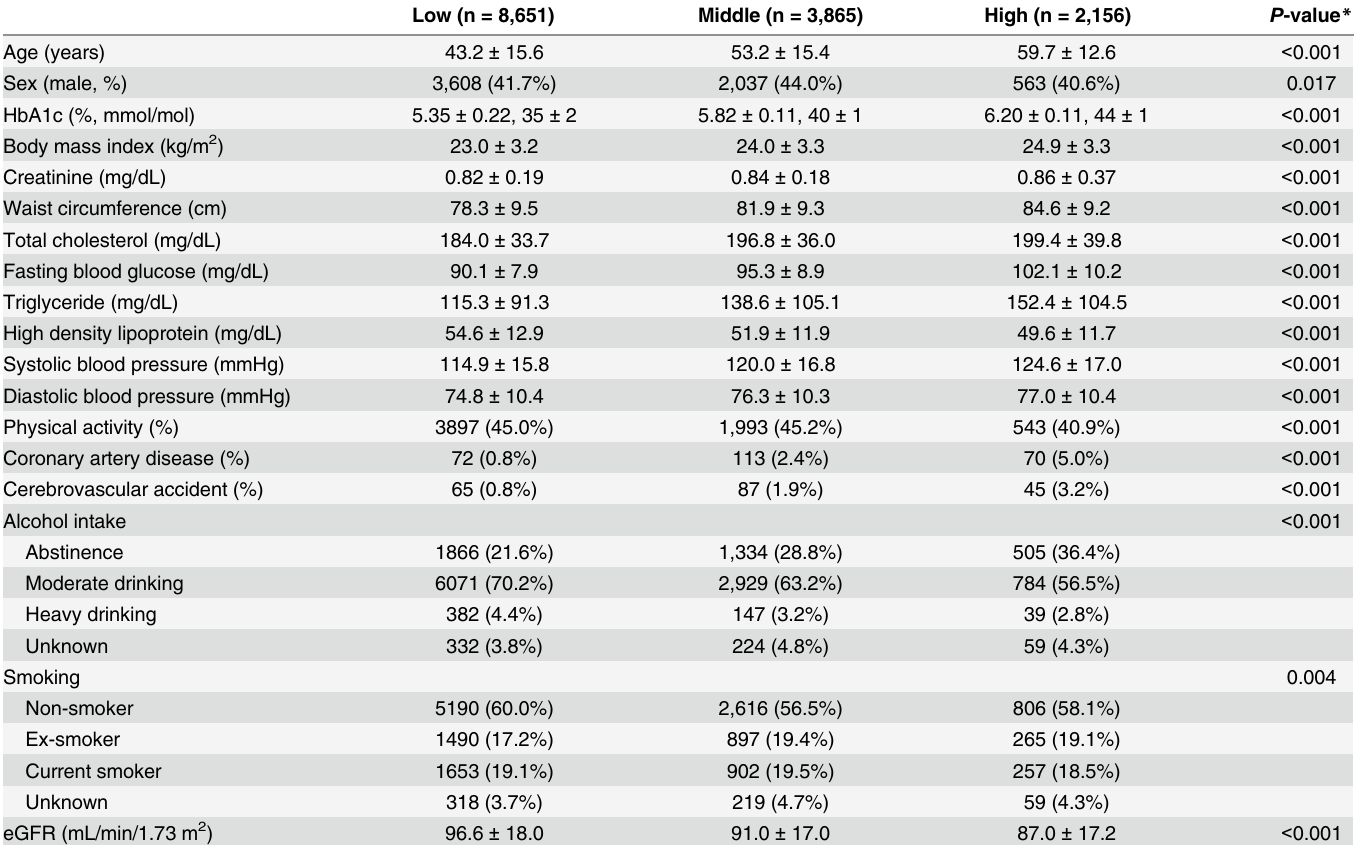
Table 1. Clinical characteristics of participants by HbA1c